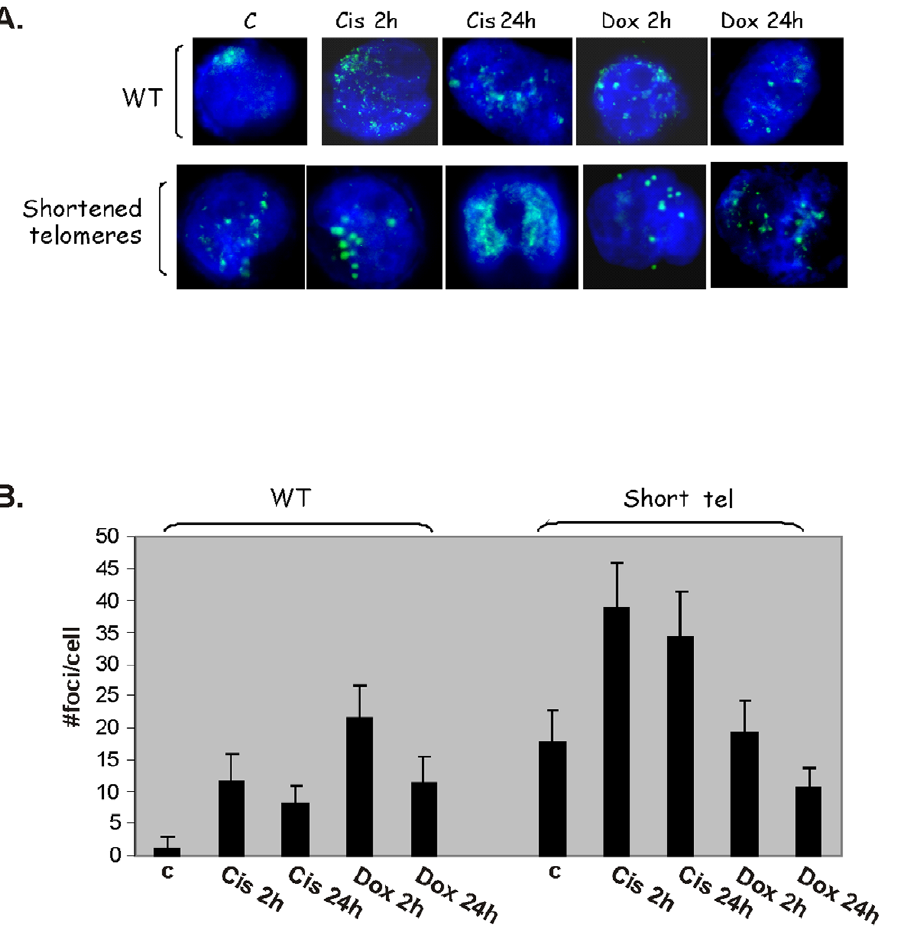
Figure 5. The formation of c H2AX foci in cells with shortened telomeres. SK-N-MC cells were exposed to cisplatinum or doxorubicin for 1 hour and then resuspended in drug free medium. The formation of c H2AX foci was followed by immunofluorescence at the indicated time points after the releasing from the drugs. Blue color indicates nuclei stained with DAPI, green foci were detected using cy2-labeled anti c H2AX antibody. A- A representative example. B- Quantitation of the number of foci per sample. Averages were calculated for at least 50 nuclei were counted for each duplicated sample and two experiments which yielded similar results.